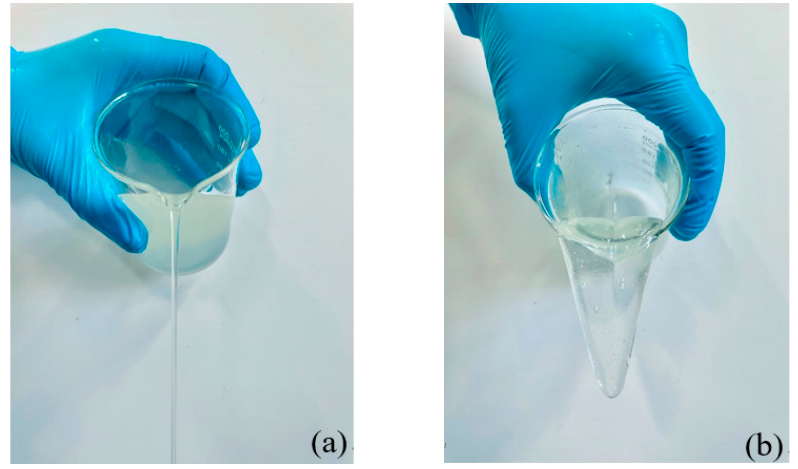
Figure 4. White flocculent precipitate formed.